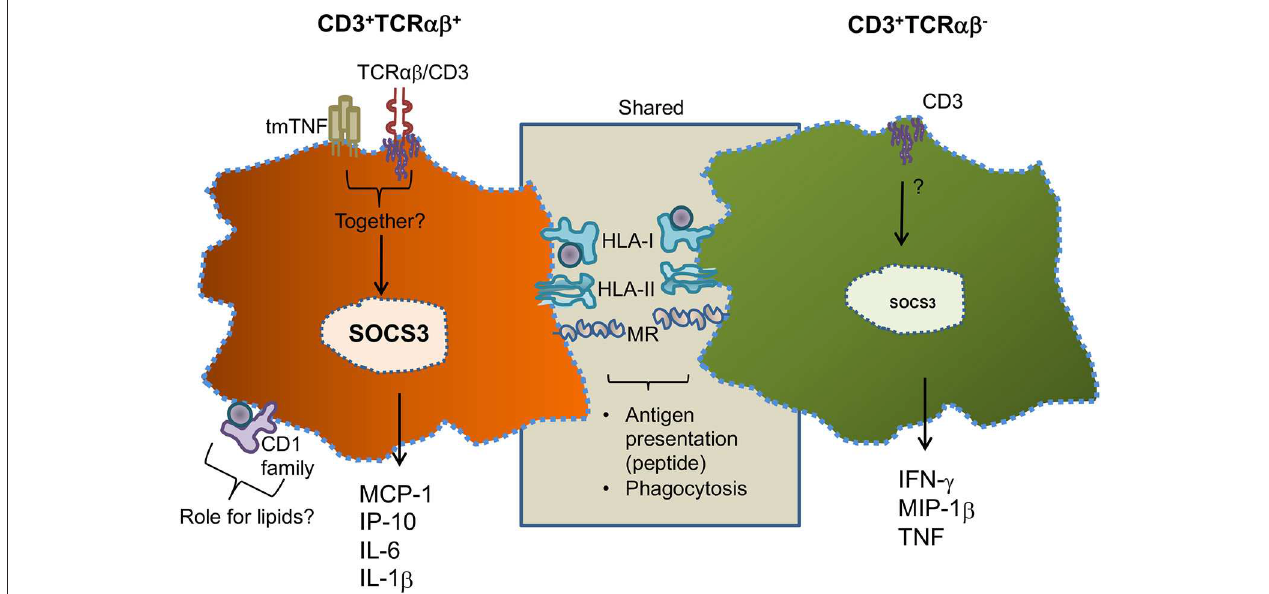
FIGURE 9 | Schematic representation of specific and shared characteristics between CD3 + TCR αβ + and CD3 + TCR αβ − MDM. Human circulating monocytes can be differentiated into CD3 + TCR αβ + and CD3 + TCR αβ − MDM; both macrophage subpopulations share characteristics, such as the expression of classic-MDM’ molecules, protein antigen presenting molecules (HLA family), and mannose receptors (MR). However, CD3 + TCR αβ + MDM co-express molecules of the CD1 family and secrete MCP1, IP-10, IL-6, and 1L-1 β by tmTNF- and CD3-dependent pathways (left) . CD3 + TCR αβ − MDM do not express tmTNF, but specifically secrete IFN- γ , MIP1- β , and TNF by a CD3-dependent pathway (right) . At this point, it is unclear whether tmTNF and CD3 act co-dependently to induce the activation of cytokines in CD3 + TCR αβ + MDM, but the SOCS3 expression is